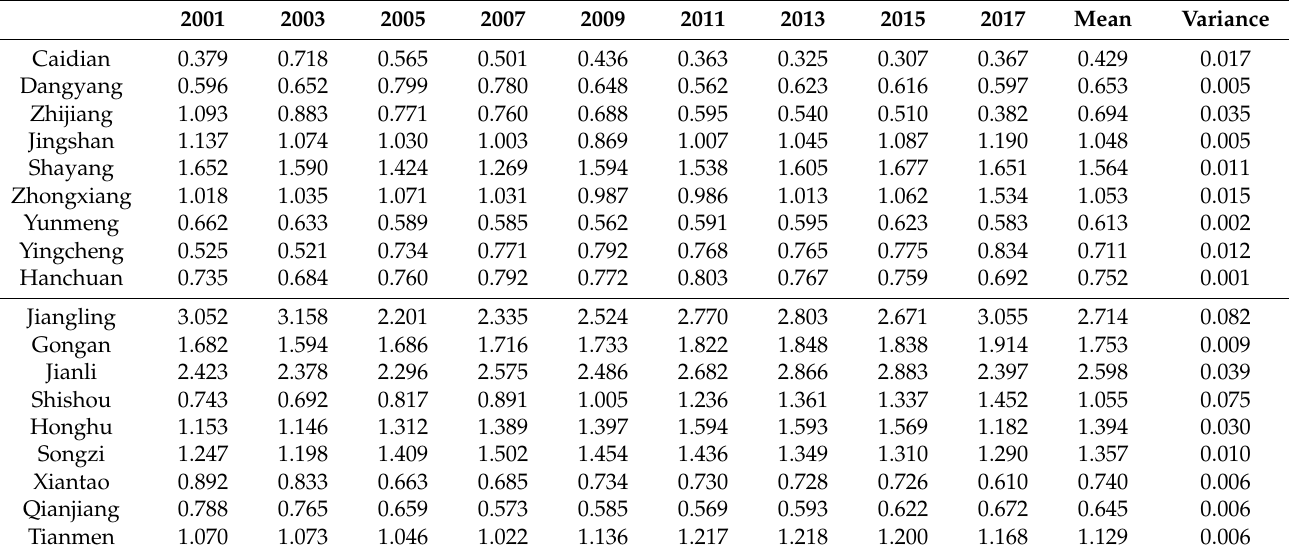
Table 2. Coefficients of the cultivated land resource curse for the county-level administrative regions in Jianghan